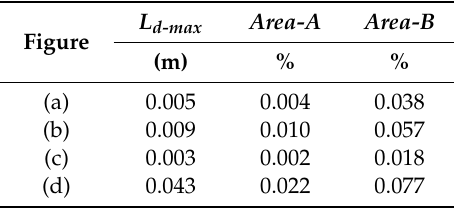
Table 3. Parameters used to evaluate the results of Figure 16.